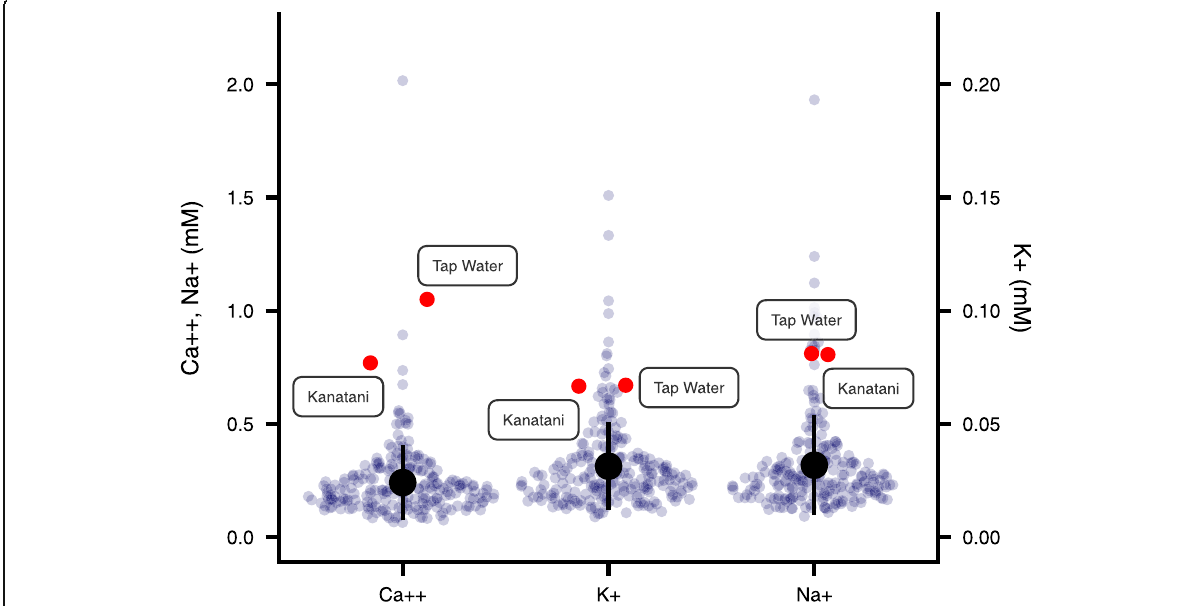
Fig. 7 Comparison of ion concentrations among rivers in Japan and water characteristics used in this study. Concentrations of calcium, potassium, and sodium ions in rivers throughout Japan are indicated by gray dots. Concentrations of calcium, potassium, and sodium ions of tap water and Kanatani water are indicated by red dots. Both the tap water and Kanatani water contain a relatively high concentration of ions compared to those of rivers in Japan. Circles and vertical bars are mean ±